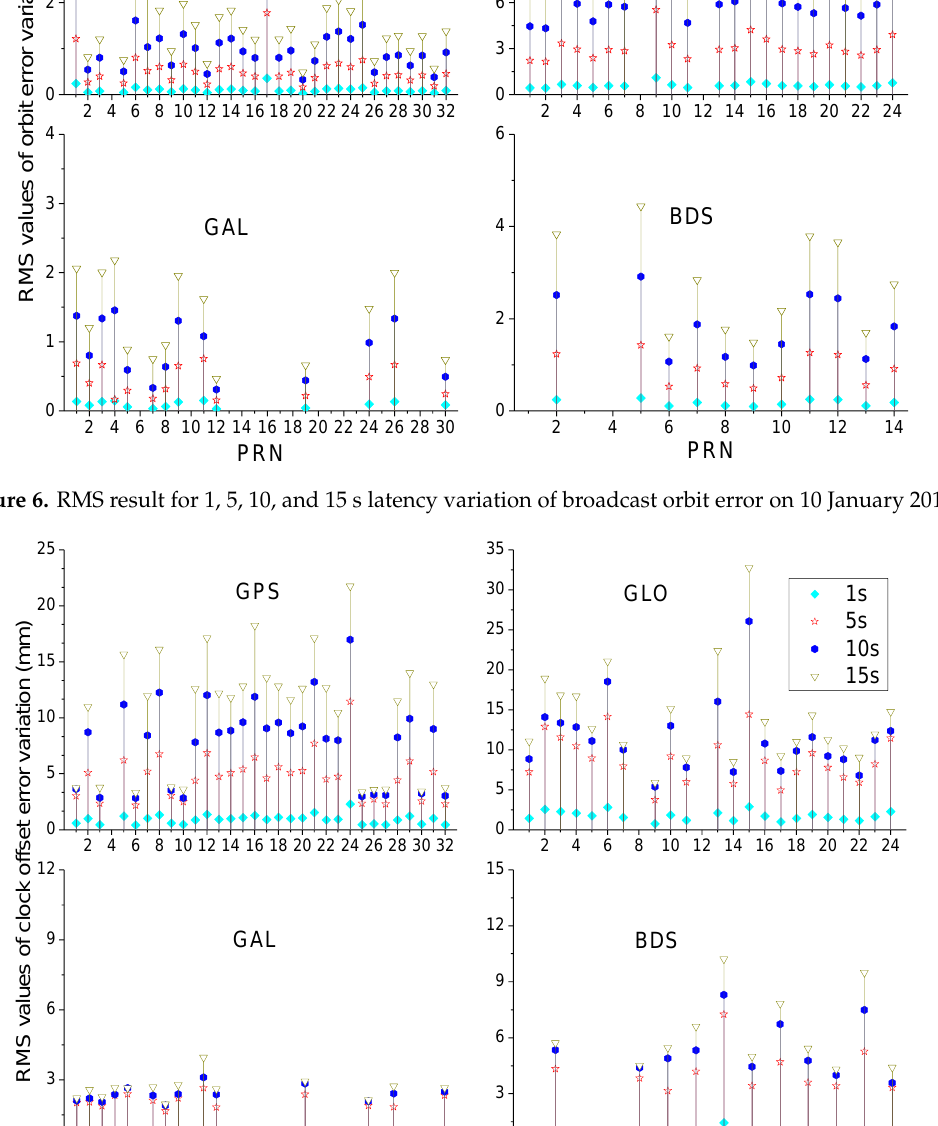
clock o ff set error variation for GPS, BDS, and Galileo. For GLONASS, the RMS value of orbit